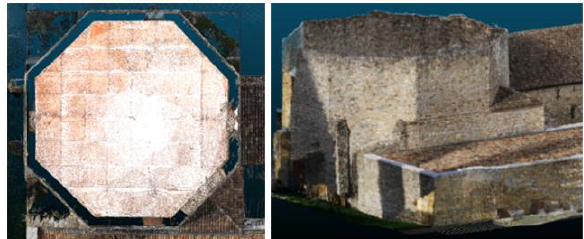
Figure 7. The current numerical model obtained by geomatic surveys (left) and the historical model